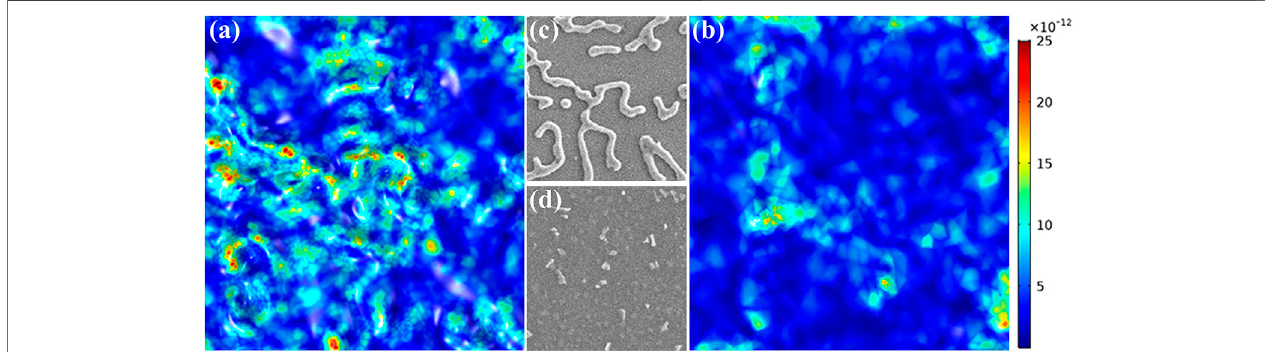
FIGURE 5 | (A) and (B) are the simulated pro fi les of the micro-electric fi eld on the fi lm surfaces. (C) and (D) are the corresponding fragments of the SEM images in the same area. (C) and (D) are under positive and negative discharge condition, respectively.